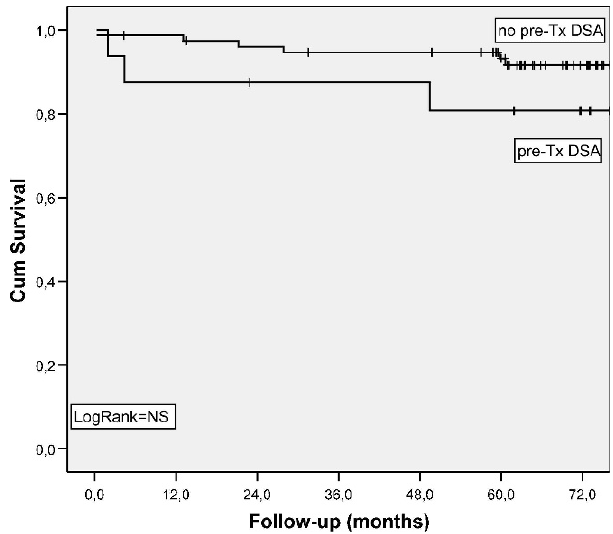
Figure 2 - Death-censored graft survival curves for the pre-Tx DSA group as compared to the